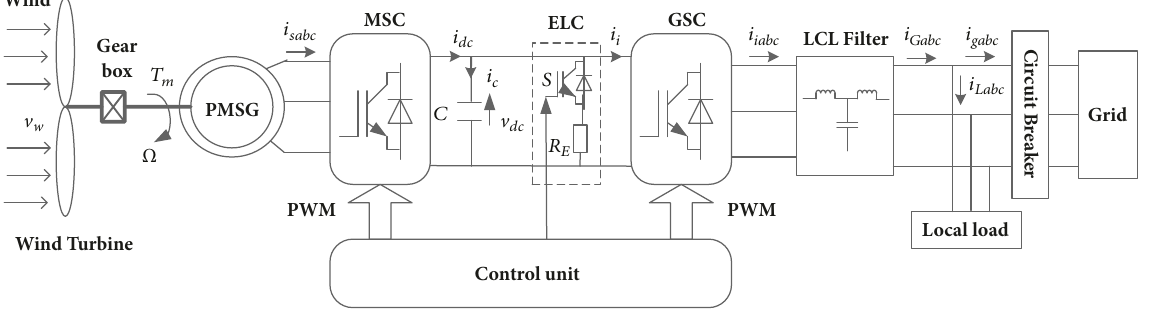
Figure 1: Control system